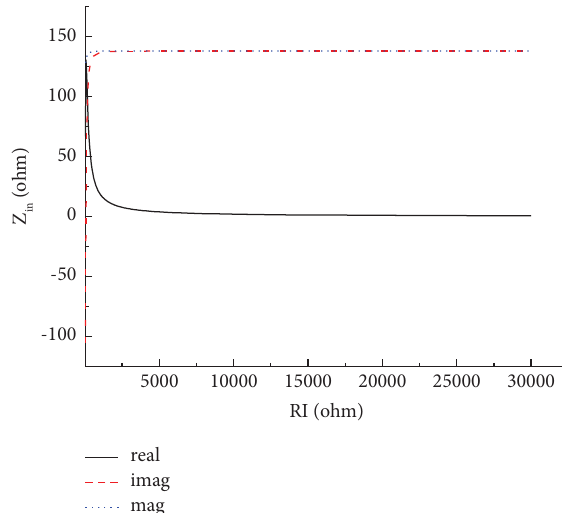
Figure 26: Te input impedance of the circuit with one branch of RCN and load shown in Figure 25.